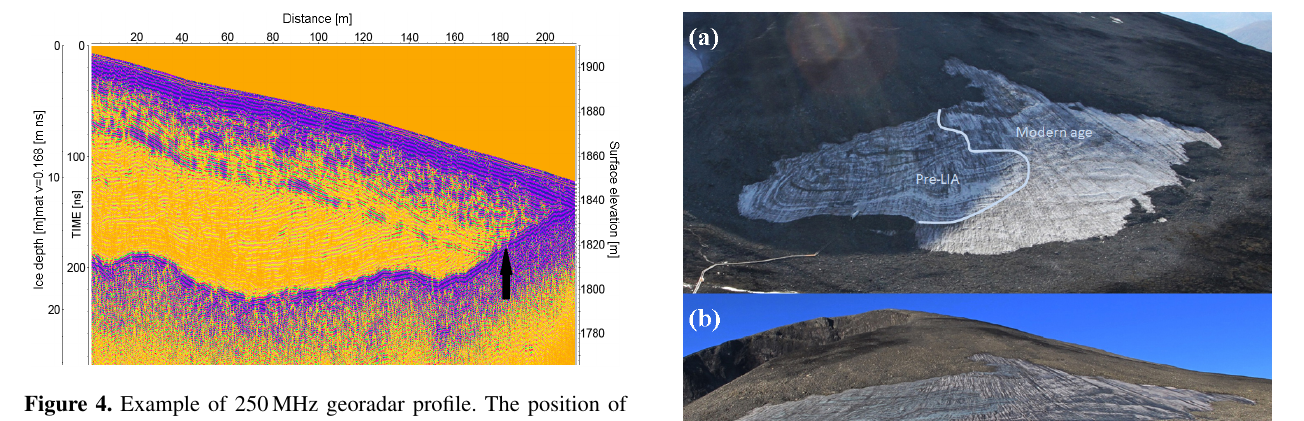
Figure 4. Example of 250MHz georadar profile. The position of the track is shown in Fig. 3b. The arrow shows the approximate minimum front position in September 2014.